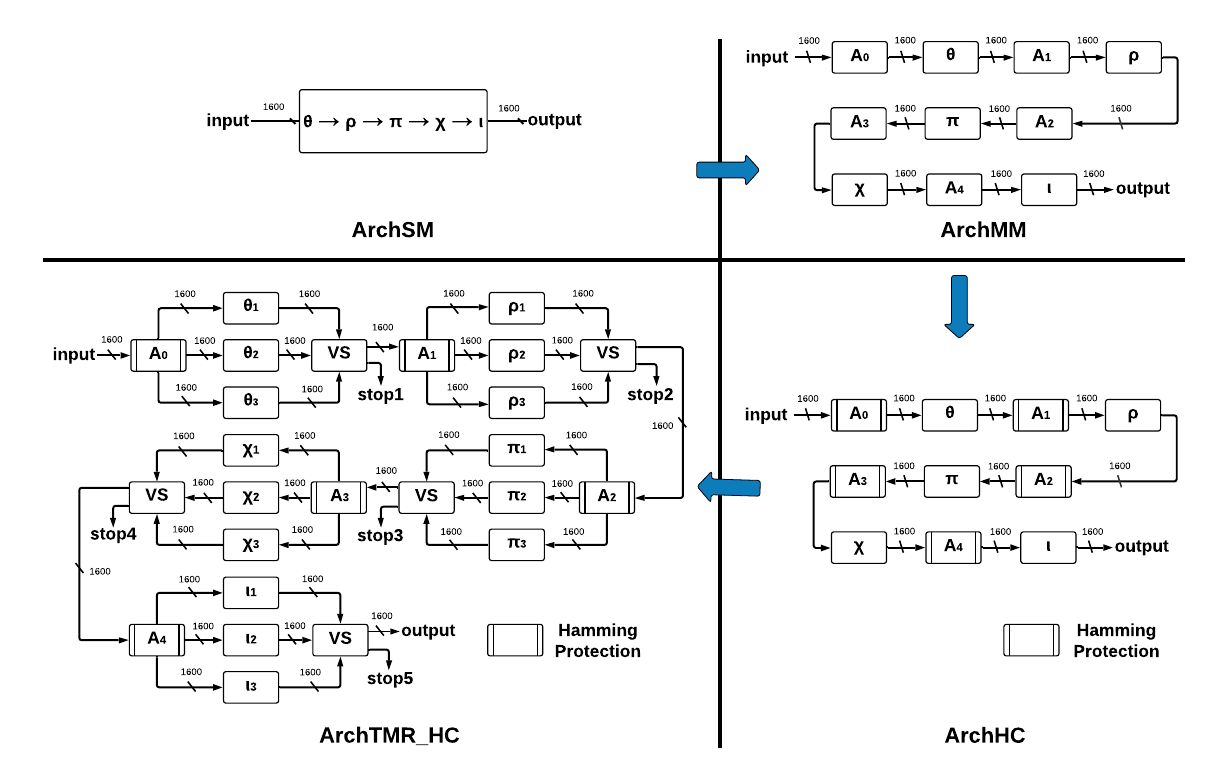
Figure 3. Development of architectures from ArchSM to